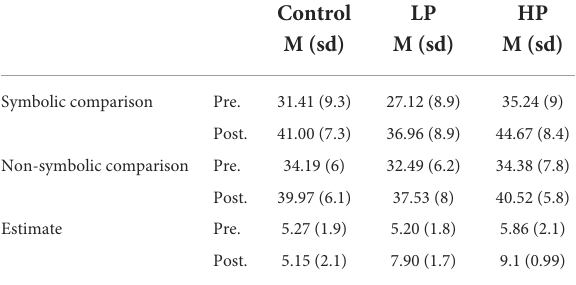
TABLE 2 Results of post-hoc tests in pairs on gains in the mathematical competence test.